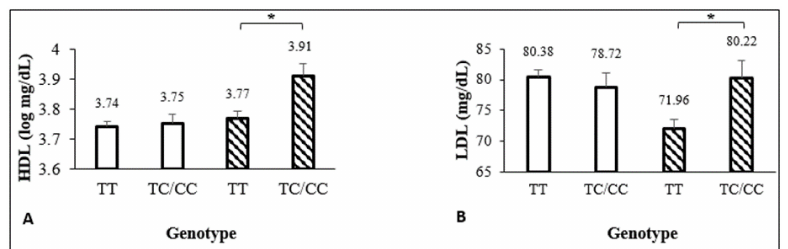
Figure 1. ( A ) Interaction between PPAR- δ mutated allele and sex: e ff ect in HDL levels. * β = -0.13 ± 0.06, p = 0.029. ( B ) Interaction between PPAR- δ mutated allele and sex: e ff ect in LDL levels. * β = 9.71 ± 4.28, p = 0.024. female,